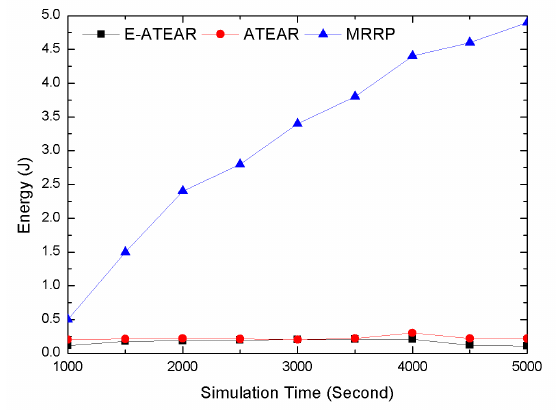
Figure 6. Average energy versus simulation